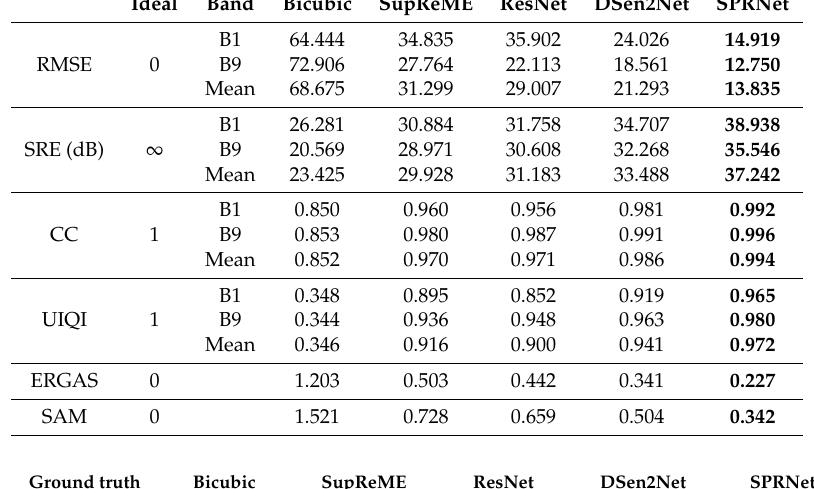
Table 5. Quantitative assessment of the SPRNet 6 Bold indicates the best performance.